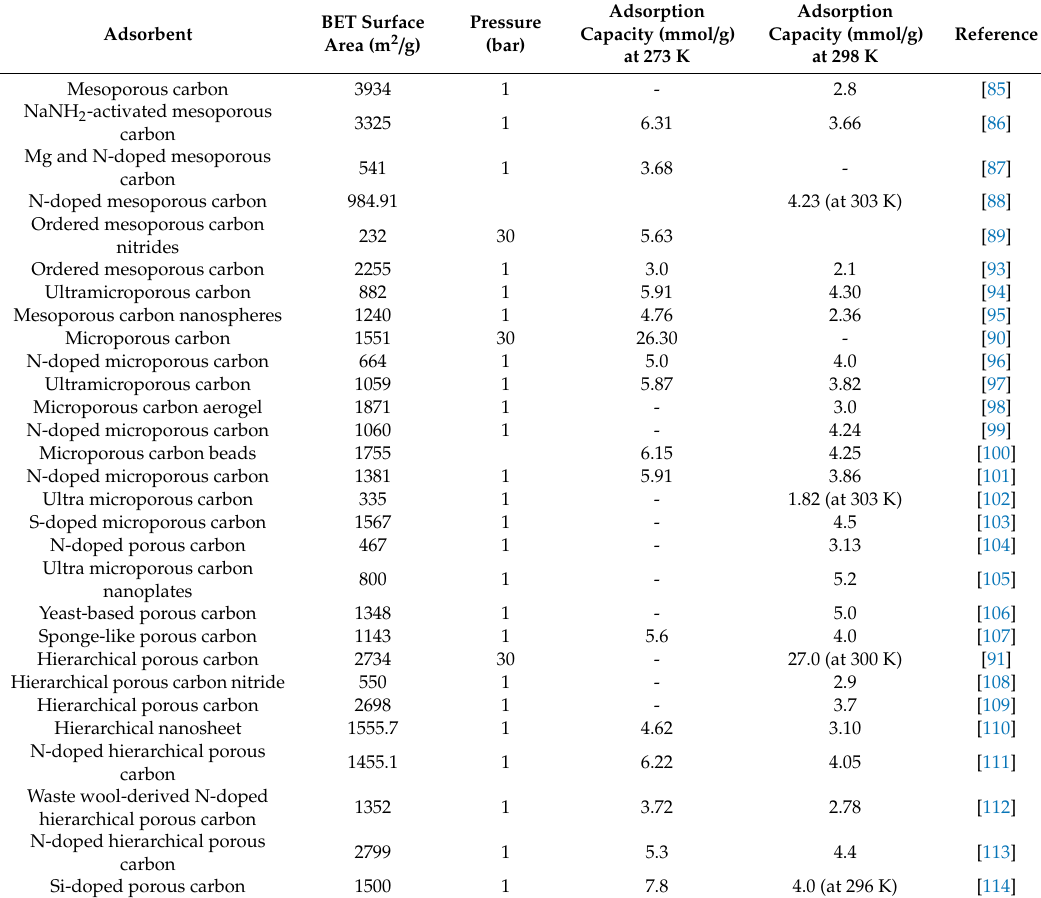
Table 4. CO 2 capture performances by microporous, mesoporous, and hierarchical porous carbons. BET Surface Pressure Adsorbent Area (m 2 / g)